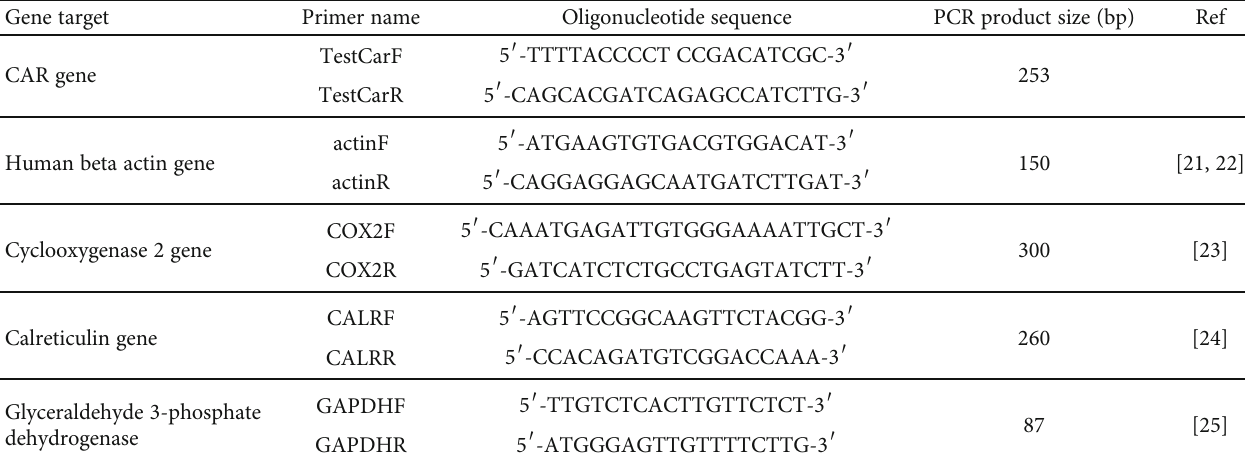
Table 1: Primer use in